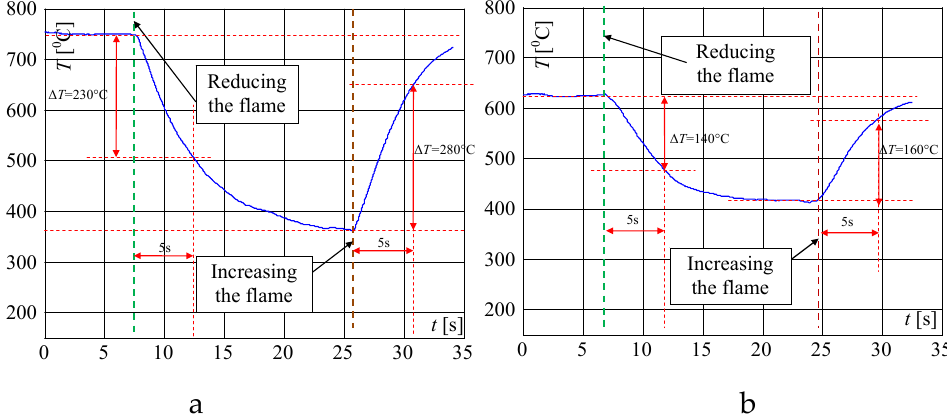
Figure 17. Temperature changes measured by the linear thermocouple in position 1, when the gas valve was closing and opening i.e., when reducing and increasing the gas flow to the burner if the pot is: ( a ) off, ( b ) on the